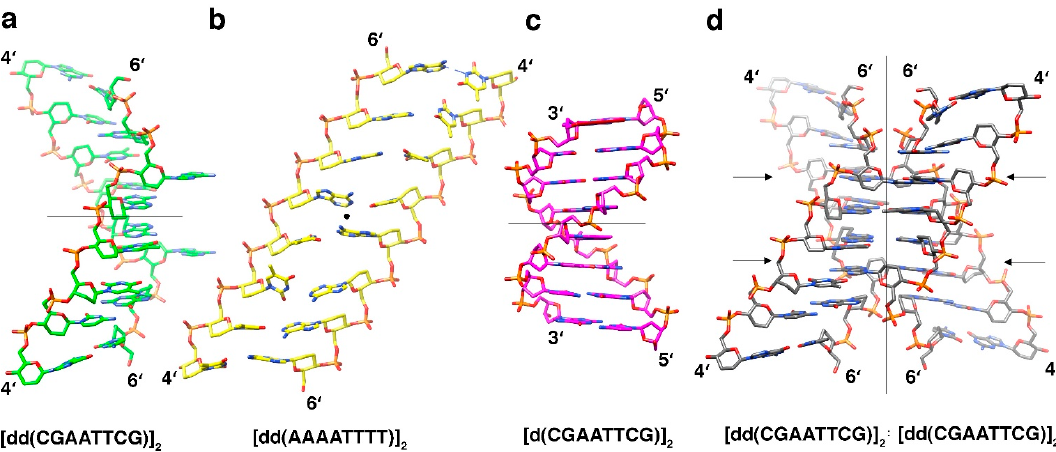
Figure 2. Three-dimensional structures of homo-DNA and DNA. ( a ) Crystal structure of the homo-DNA duplex [dd(CGAATTCG)] 2 viewed across the minor (left) and major (convex surface) grooves [13]. ( b ) NMR structure of the homo-DNA duplex [dd(AAAAATTTTT)] 2 (terminal base pairs are omitted) [16], viewed approximately along the molecular dyad (indicated with a filled circle). ( c ) Model of the DNA duplex [d(CGAATTCG)] 2 with a standard B-form geometry, viewed across the minor (left) and major grooves. ( d ) The homo-DNA tetraplex (dimer of [dd(CGAATTCG)] 2 duplexes) formed around a crystallographic dyad in space group P 6 1 22 and featured swapping of nucleobases and reverse-Hoogsteen A:T pairs at two sites (arrows). Molecular (panels ( a ) and ( c )) or crystallographic dyads (panel ( d )) are indicated by thin solid lines, and carbon, nitrogen, oxygen, and phosphorus atoms are colored green (panel ( a ); yellow in ( b ), magenta in ( c ), and gray in ( d )), blue, red, and orange, respectively.